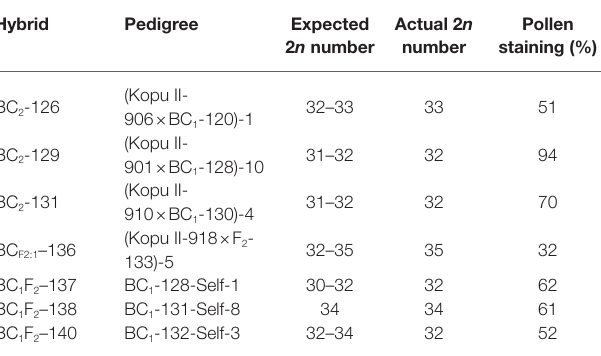
TABLE 3 | Selected BC 2 , BC F2:1 and BC 1 F 2 progeny with expected and actual chromosome numbers and pollen fertilities. Hybrid